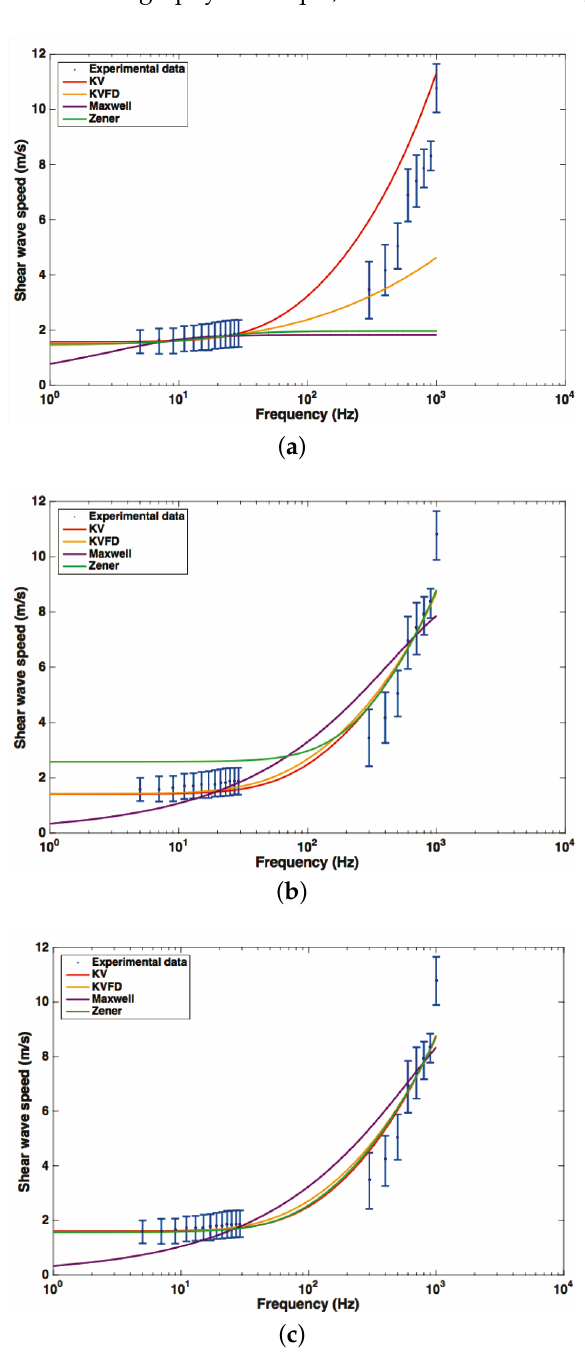
Figure 12. Fitted curves using data from rheometry, from elastography and using the combined data from the rheometry and elastography for each model. The circles are the mean values over the three cervix and the horizontal bars are the standard deviations. The curves for the Kelvin–Voigt (solid red line), Kelvin–Voigt Fractional Derivative (solid yellow line), Maxwell (solid purple line) and Zener model (solid green line) are shown. ( a ) data from rheometry; ( b ) data from elastography; ( c ) data from rheometry and